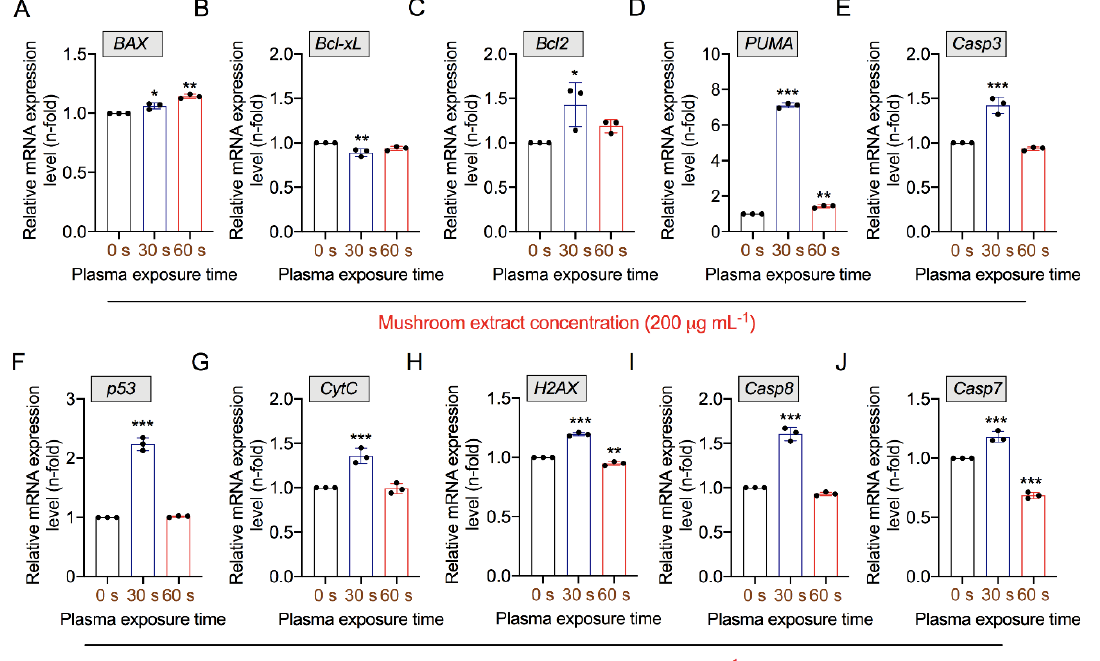
Figure 8. Induction of cell death markers by plasma-treated mushroom-derived extracts . ( A – J ) Quantification of mRNA expression of BAX , Bcl-xL , BCl2 , PUMA , Casp3 , p53 , CytC , H2AX , Casp8 , and Casp7 apoptosis-related markers, respectively in MCF7 cells treated at 200 µg mL −1 concentration. * p < 0.05, ** p < 0.01, and *** p < 0.001.